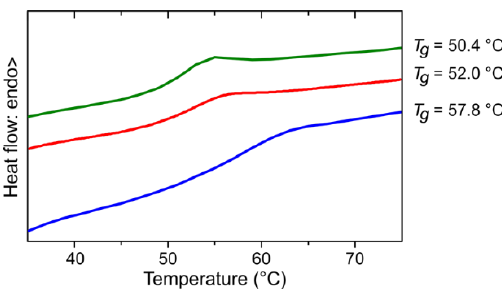
Figure 5. Differential scanning calorimetry thermograms (second-heating) for PPM synthesized with the catalyst [W 2 Br 4 (CO) 7 ] (red) and the fractions F1 (green) and F4 (blue) thereof. The glass transition temperature ( T g ) is indicated at the right side of the respective curve. The color code corresponds to that of the colors of Figure 4.